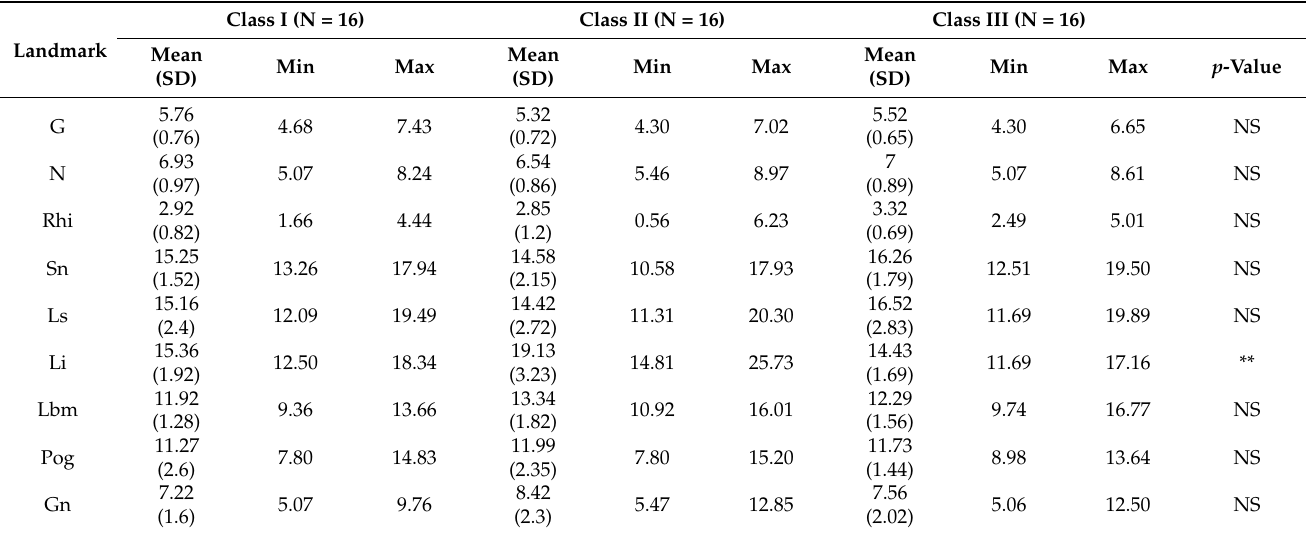
Table 1. The differences between three skeletal classes in FSTT in Korean